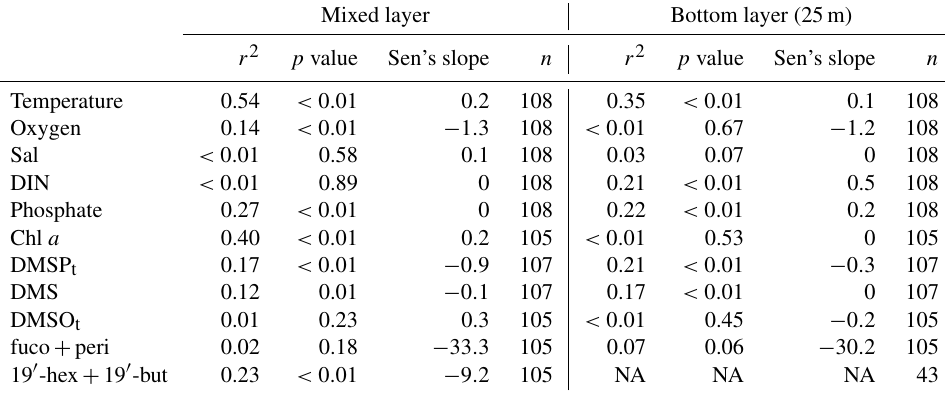
Table 3. Statistics of the linear regression of the temporal trends for the anomalies of temperature ( ◦ C), dissolved oxygen (µmolL − 1 ), salinity, dissolved inorganic nitrogen (DIN; µmolL − 1 ), phosphate (µmolL − 1 ), Chl a (µgL − 1 ), DMSP t (nmolL − 1 ), DMS (nmolL − 1 ), DMSO t (nmolL − 1 ), the sum of pigments of fucoxanthin (fuco) and peridinin (peri) (ngL − 1 ), and 19 (cid:48) -hexanoyloxyfucoxanthin (19 (cid:48) -hex) and 19 (cid:48) -butanoyloxy-fucoxanthin (19 (cid:48) -but) (ngL − 1 ). r 2 : coefficient of determination in the simple linear regression calculated by the